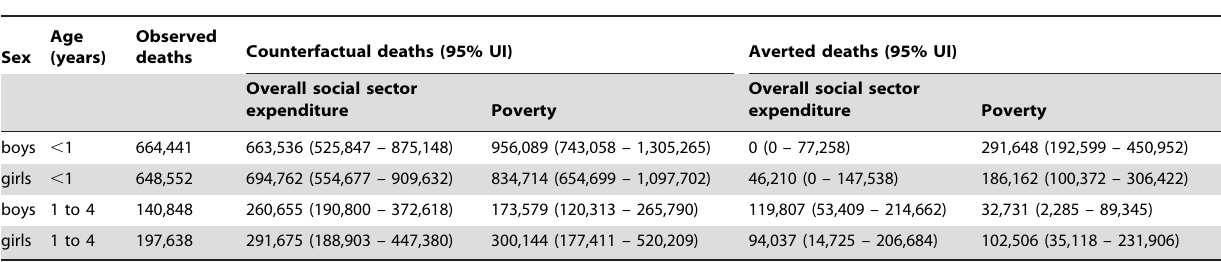
Table 2. Observed, counterfactual, and averted deaths in